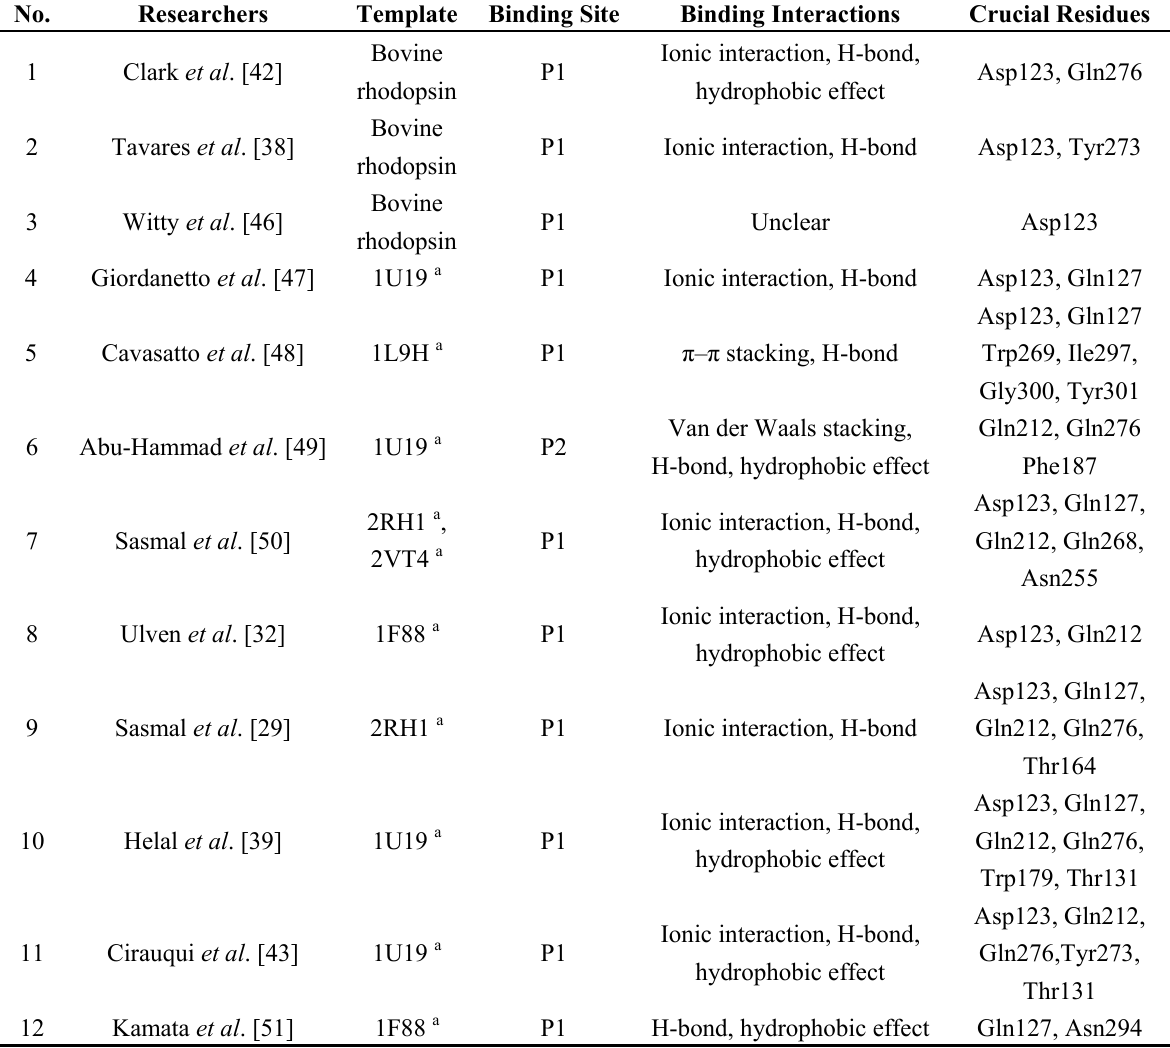
Table 2. Important information of docking studies performed by other